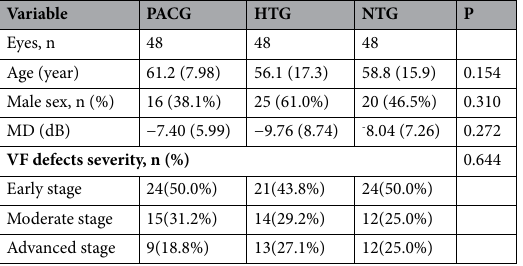
Table 2. Demographic characteristics of the matched participants. Data are mean ± standard deviation unless otherwise indicated. MD mean deviation, VF visual